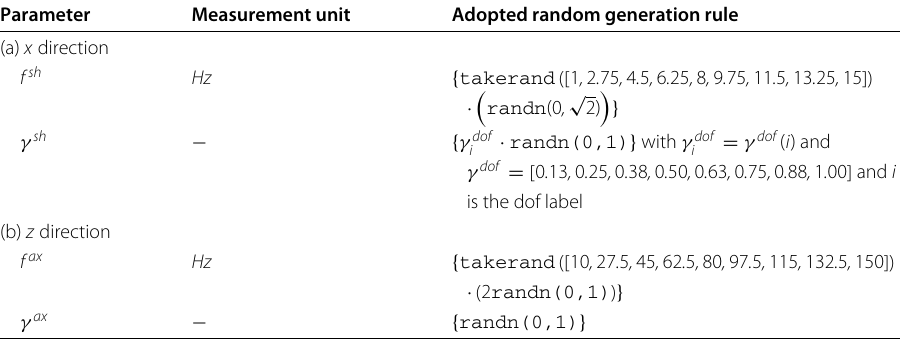
Table 2 Adopted random generation rules for the parameters η 1 sh frequency and the magnitude of the applied sinusoidal load components in the x (a) and z (b) directions respectively Parameter Measurement